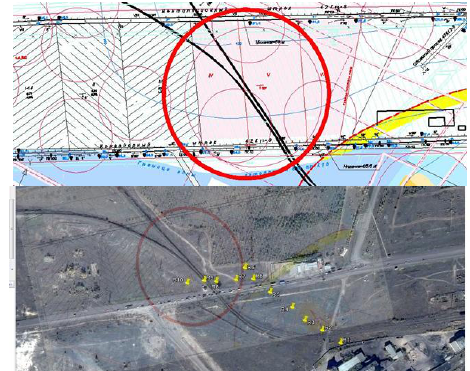
Figure 1. Determination of the undermined territory and overlapping on the territory plan in Google